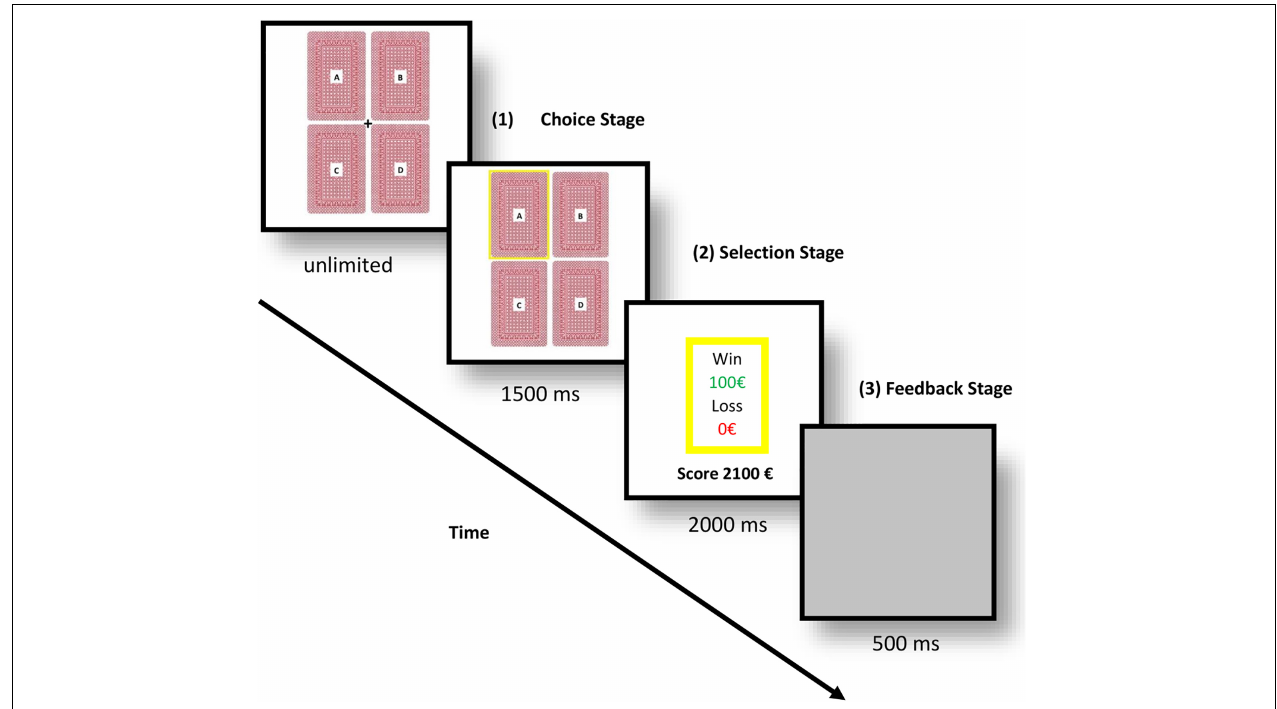
FIGURE 1 | Experimental flow of the adapted version of the Iowa gambling task (IGT) for event-related potentials